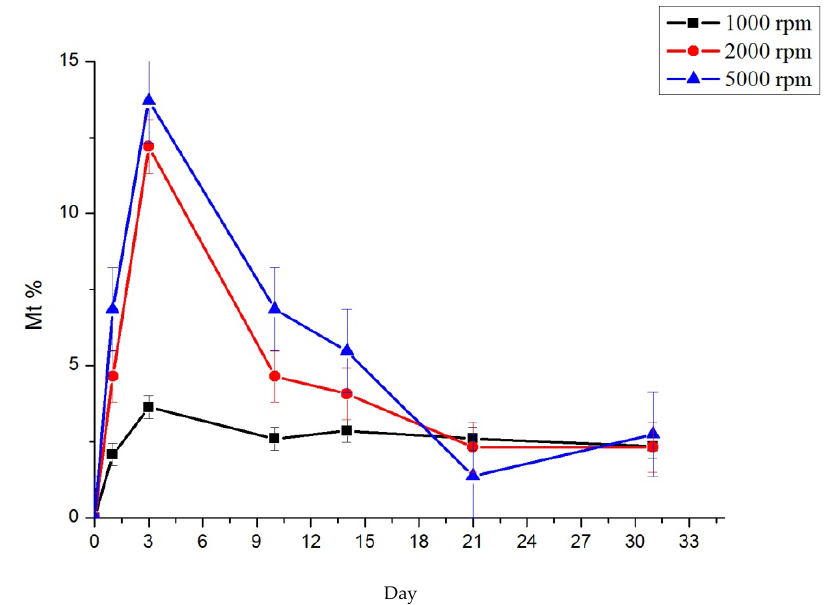
Figure 5. Mass variation (Mt%) as aging time increases for pure resin samples at 1000 rpm, 2000 rpm, 5000 rpm .